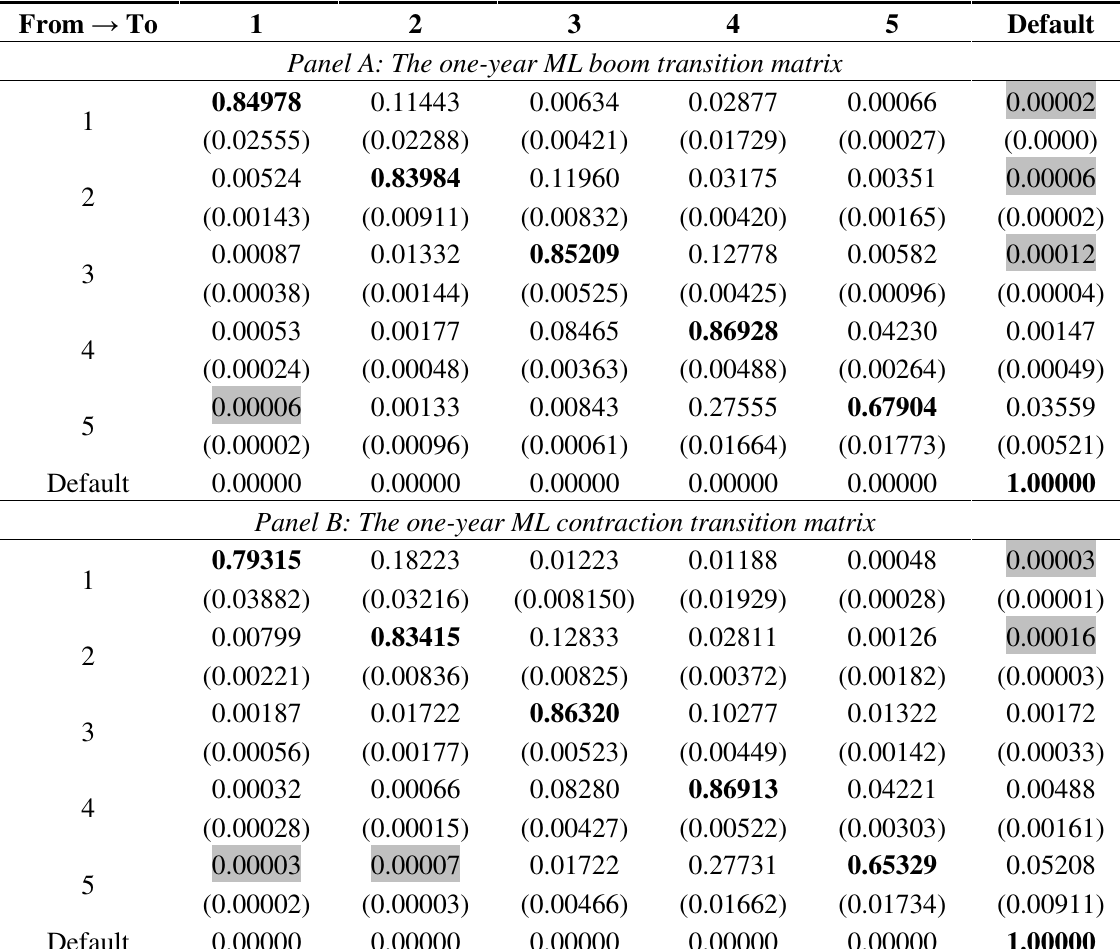
Table 3. Transition probabilities in time-homogeneity: Discrete-time maximum likelihood (DTML) results on business cycle